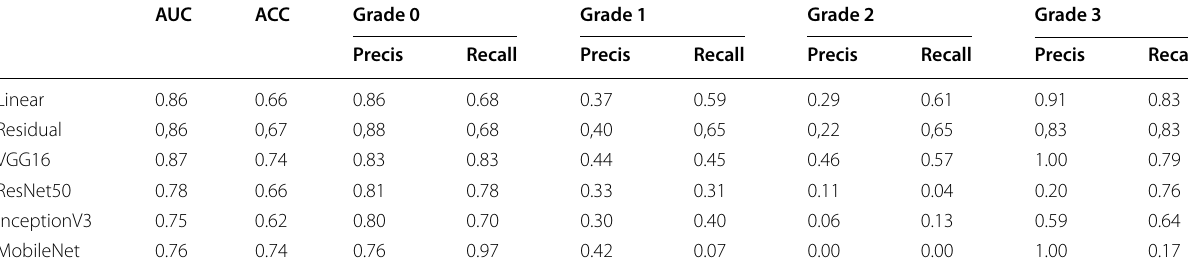
ACC accuracy; AUC =